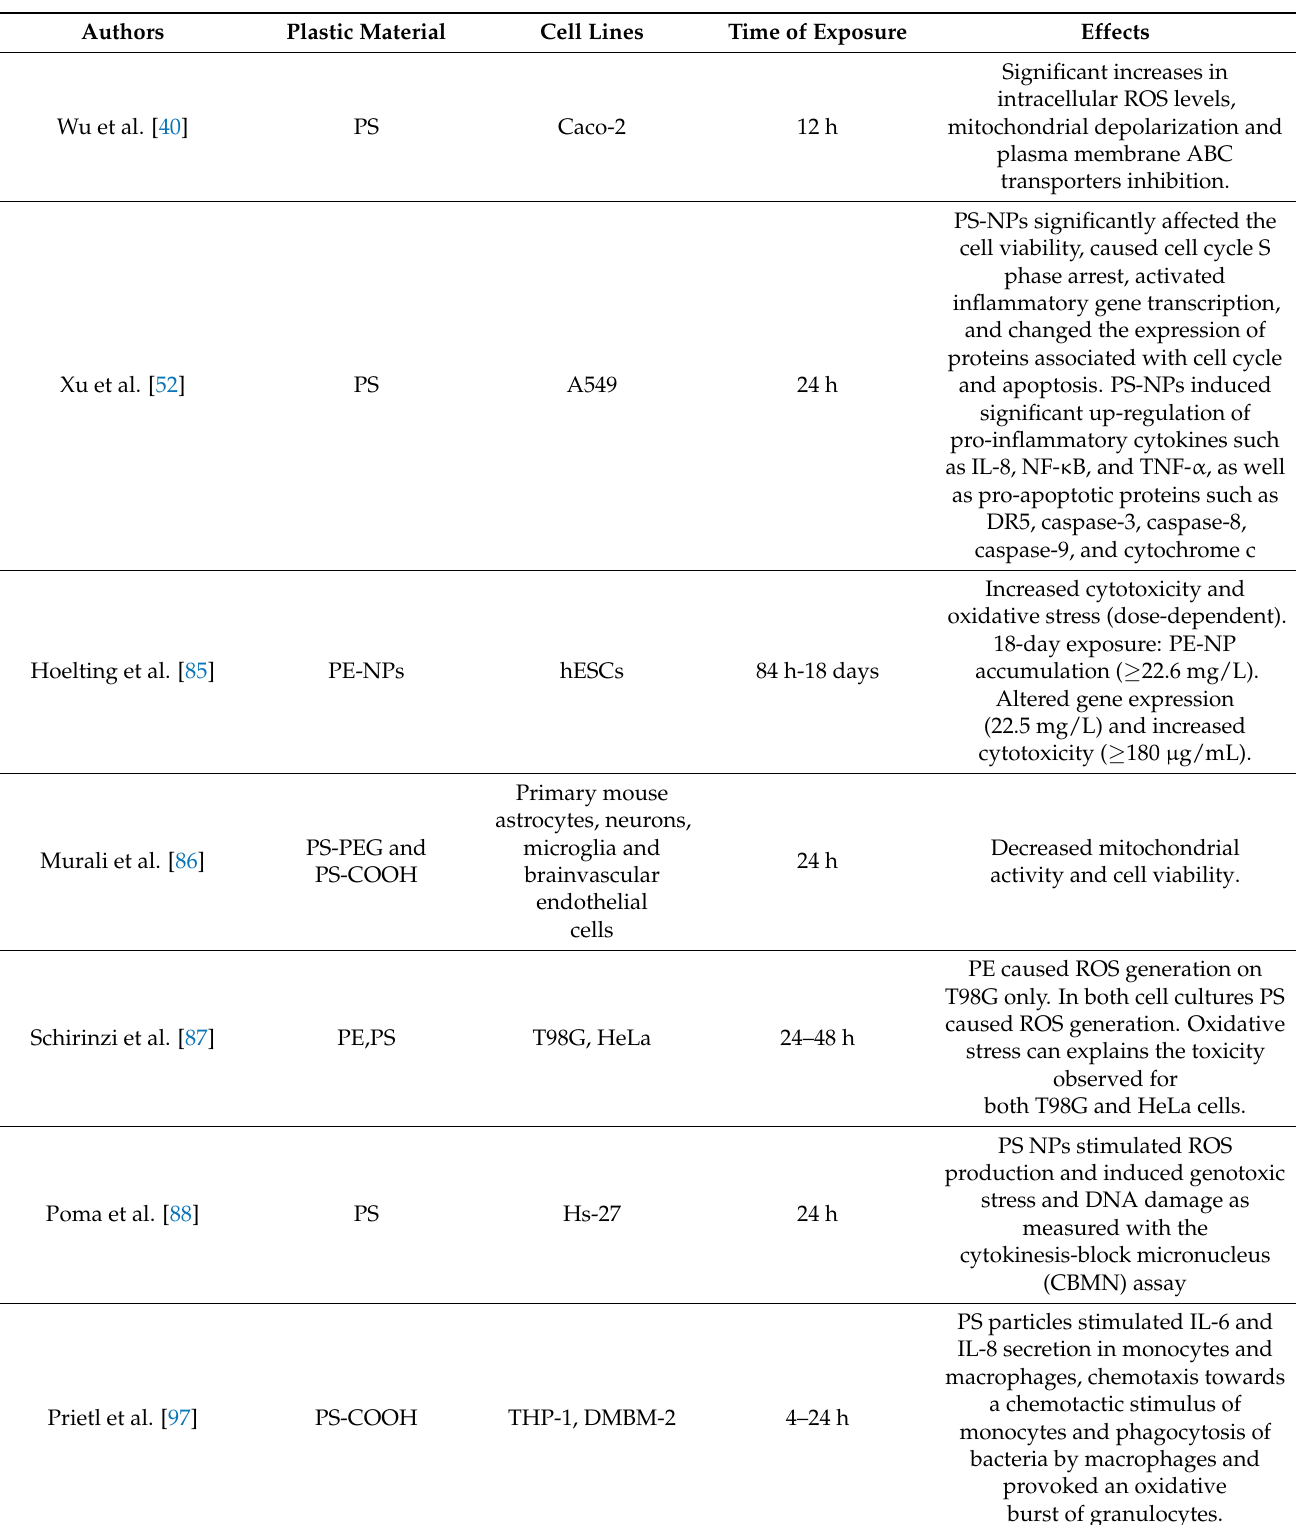
Table 1. In vitro studies of plastic material effects: oxidative stress, mitochondrial damage, cytotoxicity, and inflammation in different cell